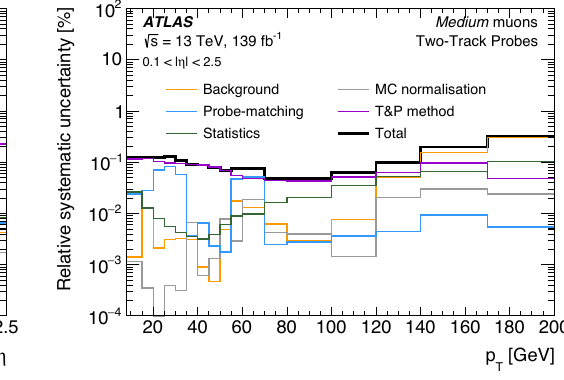
Fig. 7 Relative contributions to the systematic uncertainty in the effi- ciency SFs for Medium muons measured with Z → μμ decays, as a function of η (left) and p T (right) for muons with p T > 10 GeV, and integrated over the other kinematic observables. The uncertainty